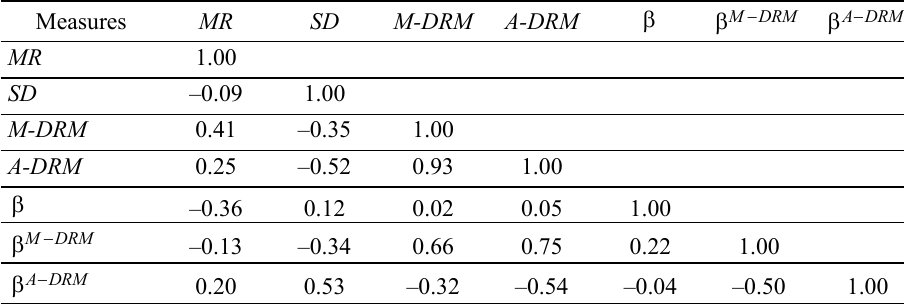
Table 2. Correlation matrix of full sample